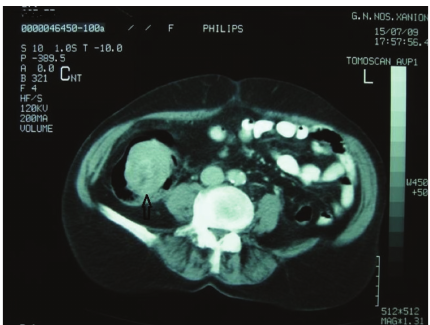
Figure 1: Contrast-enhanced abdominal CT revealing the presence of a mass at the cecum level